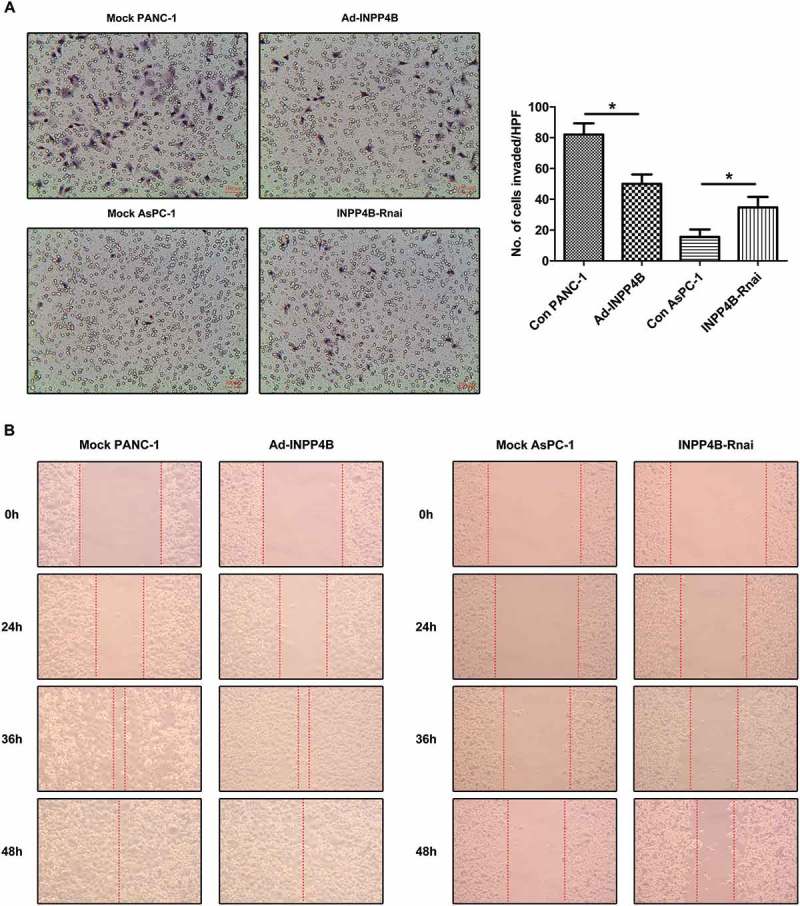
Transwell invasion assay and wound healing assay. (a) PANC-1 and AsPC-1 cells, untreated or undergone INPP4B upregulation/knockdown, were assessed for in vitro invasiveness through Matrigel, and the number of cells invaded through the Transwell system was recorded. (b) Representative images of wound healing assay were produced after scraping for 0 h, 24 h, 36 h and 48 h. Scale bar in images = 100 mm. Results show mean ± SD (n = 3). N/S and * indicate P> 0.05 and P < 0.05.